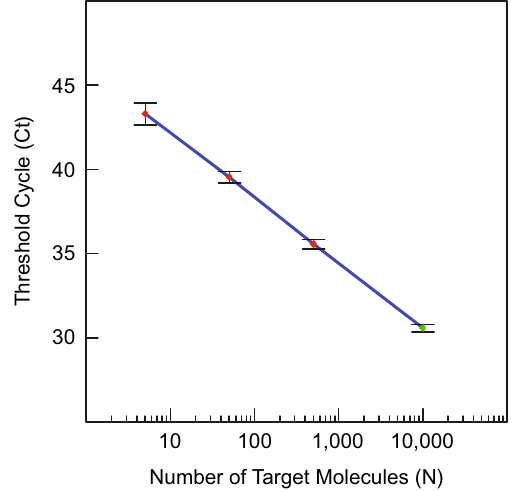
Figure 4. Inverse linear relationship between the mean Ct value of each set of EGFR G719C mutant DNA sequences (red dots) and the logarithm of the amount of those target DNA molecules present in each sample, including the mean Ct value of the β-actin reference gene fragments (green dot) contained in the 10,000 copies of the entire human genome. The standard deviation of each mean Ct value is indicated by vertical bars. The relatively larger standard deviation of the Ct values for samples that nominally contained five EGFR G719C mutant target DNAs reflects the Poisson distribution of these few template molecules among the ten reaction